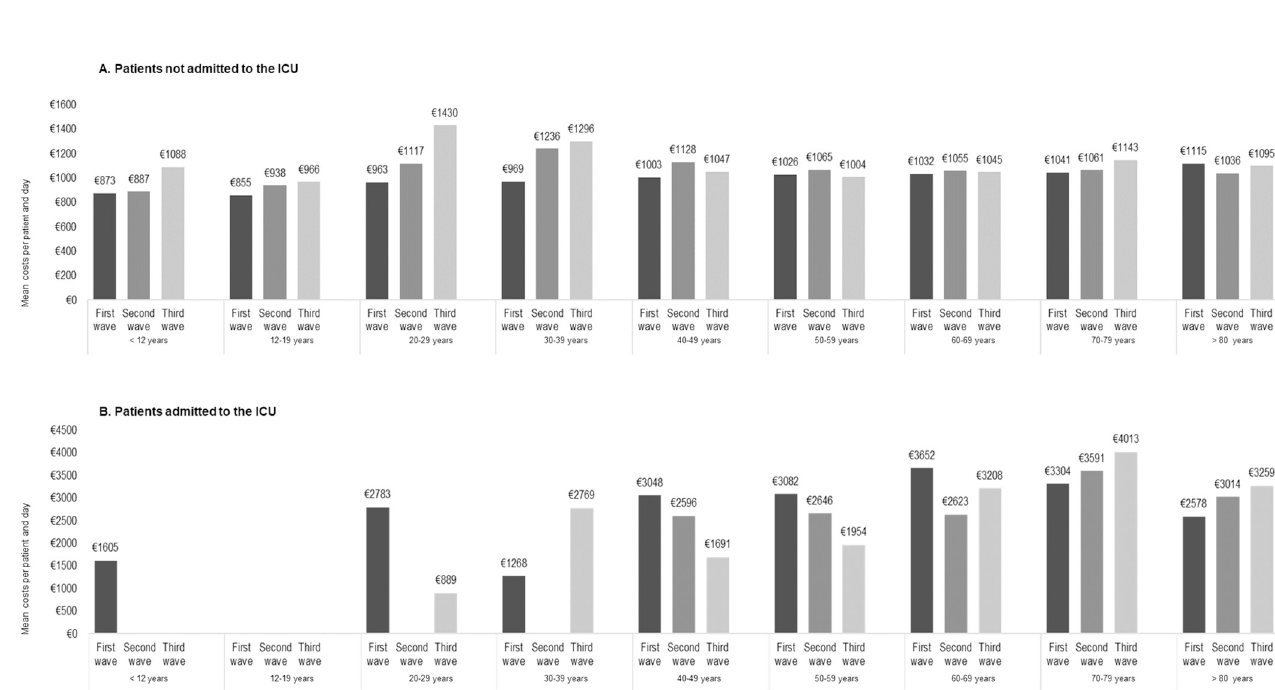
Fig 4. Mean costs per patient and day associated with COVID-19 hospitalization in the different outbreak waves stratified by the vaccination age bands for patients who were not (A) and who were (B) admitted to the ICU. Abbreviations: ICU (intensive care unit). Costs are estimated as unadjusted means.